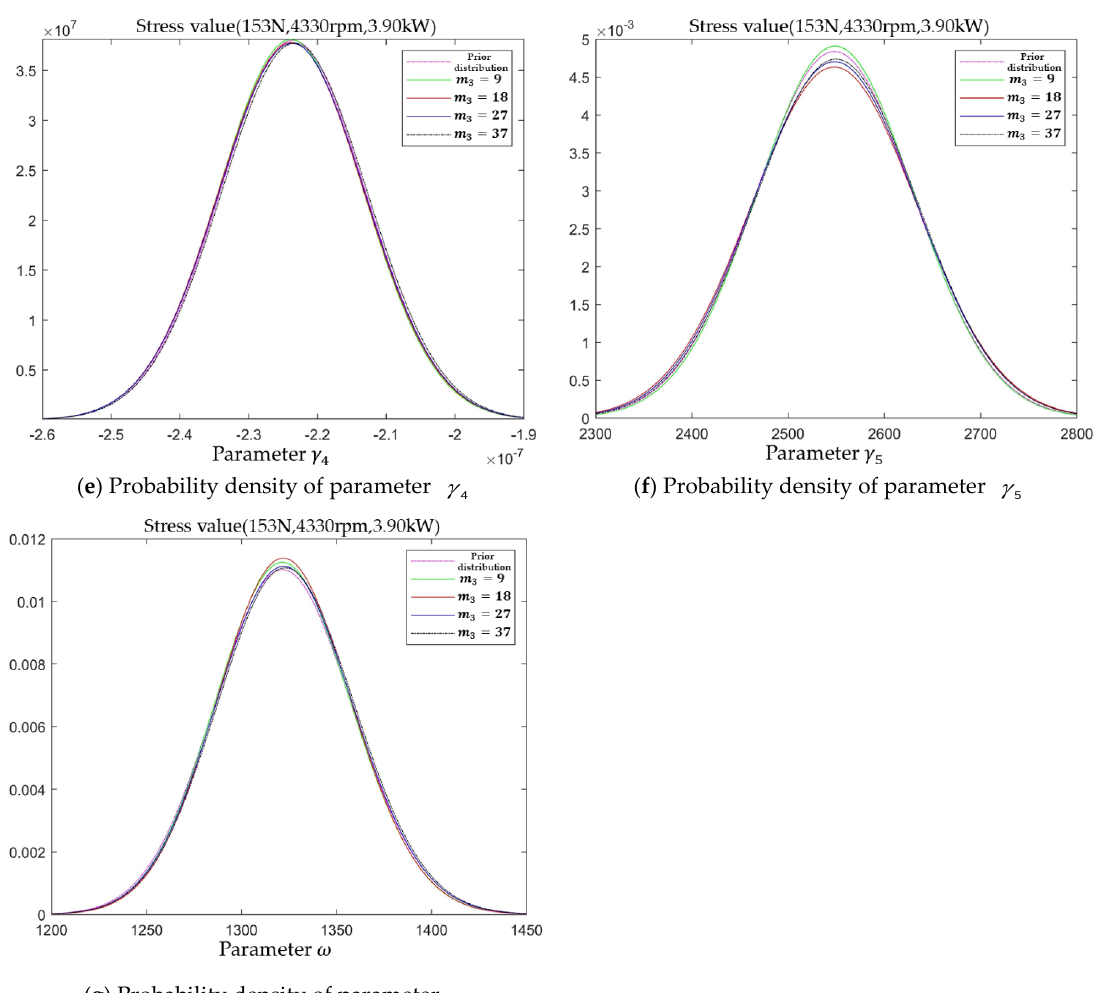
Figure 11. The update process of probability density of each model parameter with the test ( l = 3) Compared with Figure 10, the posterior distribution probability density functions of